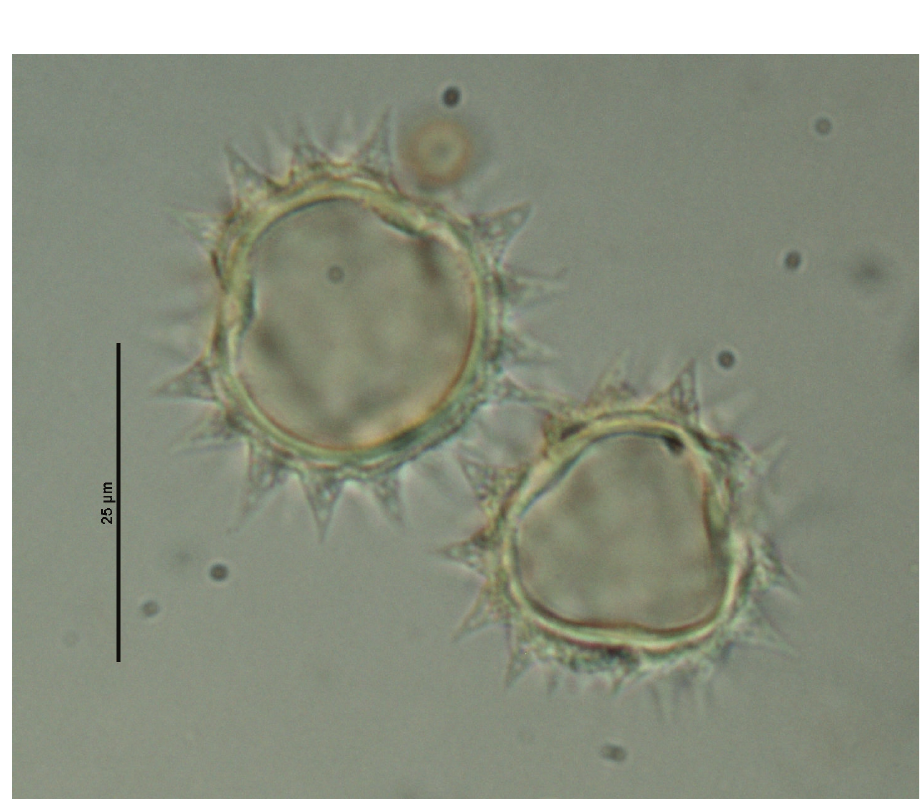
Figure 3 . Pollen from brood cells of Pseudoanthidium tenellum with the dominance of the Bidens pollen